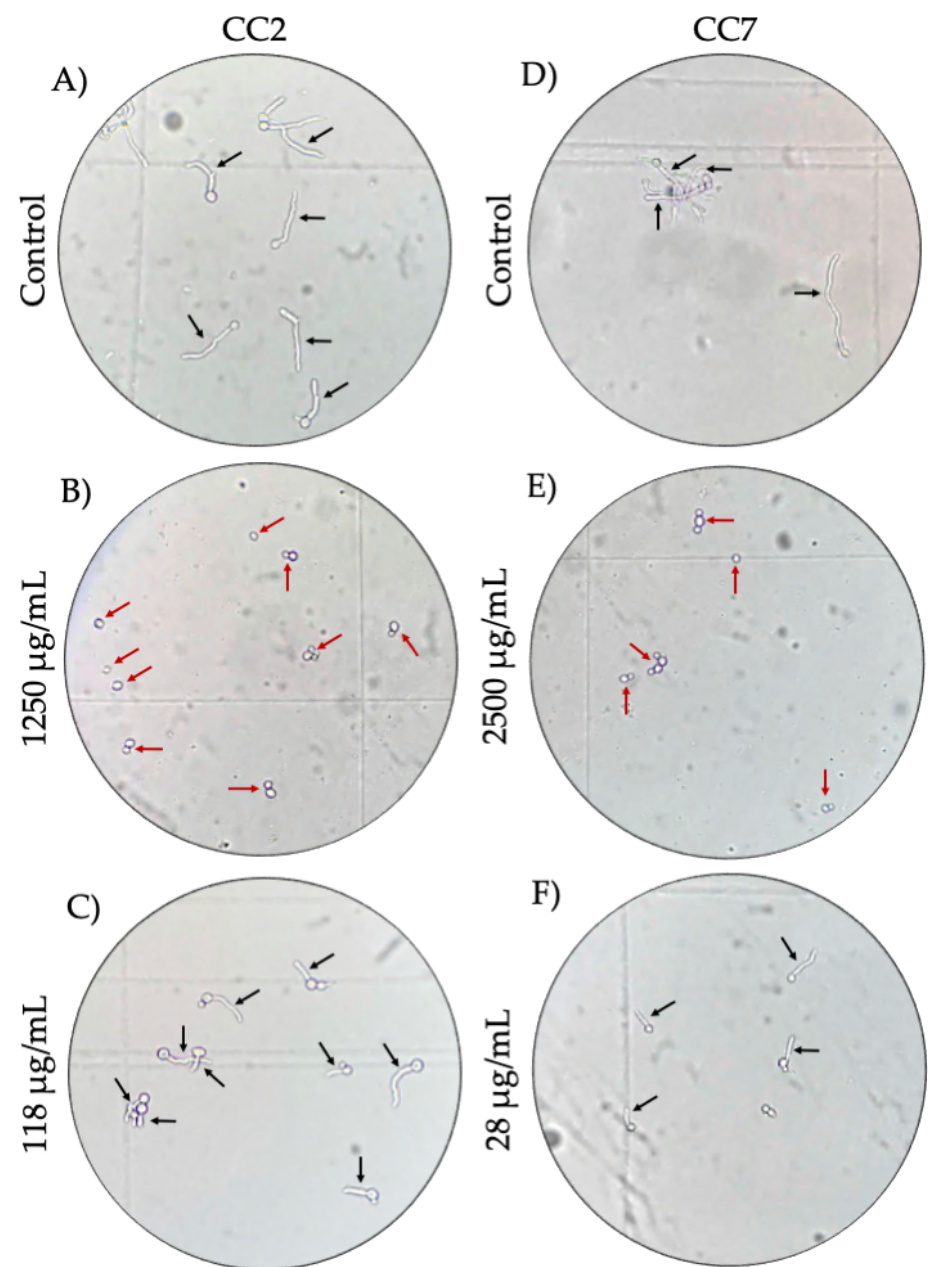
Figure 3. Representative microphotographs (40×) of the inhibitory effect of propolis on the germ tube growth of C. albicans . Black arrows point to the germ tubes of C. albicans . Red arrows point